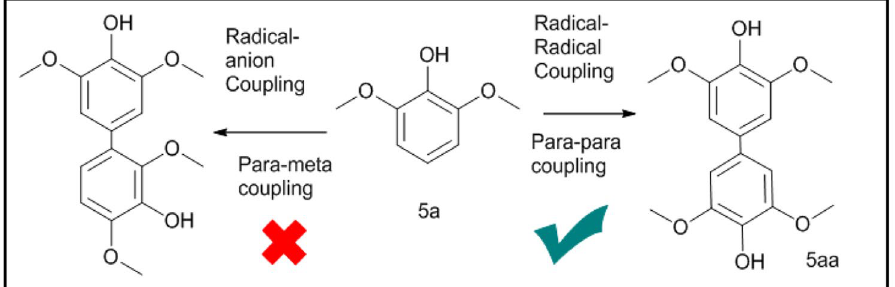
Figure 2. Selective homo-coupling of 2,6-di-methoxy phenol (5a): (right side) para-para coupled product (5aa) due to radical–radical coupling; (left side) para-meta coupled product due to radical-anion coupling reaction mechanism.